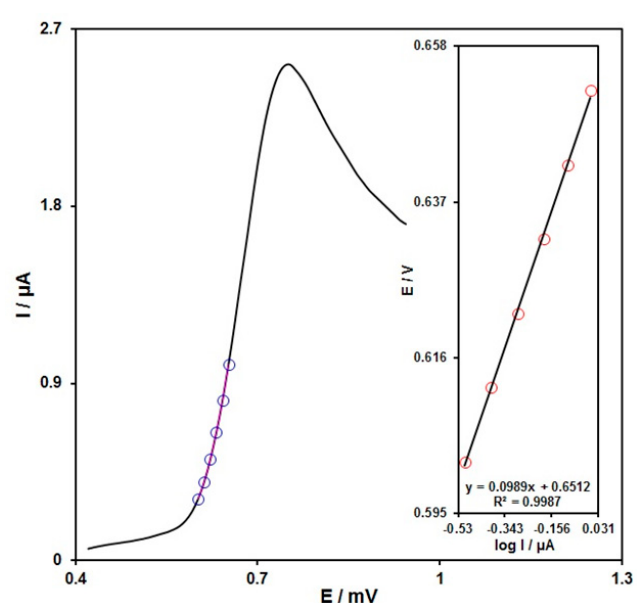
Figure 5. The LSV curves for INZ (100.0 µM) in PBS (0.1 M, pH 7.0) at different scan rates (10 to 400 mV/s) on MoS 2 NSs-SPE (a–f: 10 mV/s, 50 mV/s, 100 mV/s, 200.0 mV/s, 300.0 mV/s, and 400.0 mV/s, respectively). Inset: plot of INZ oxidation peak current against square root of scan rate.